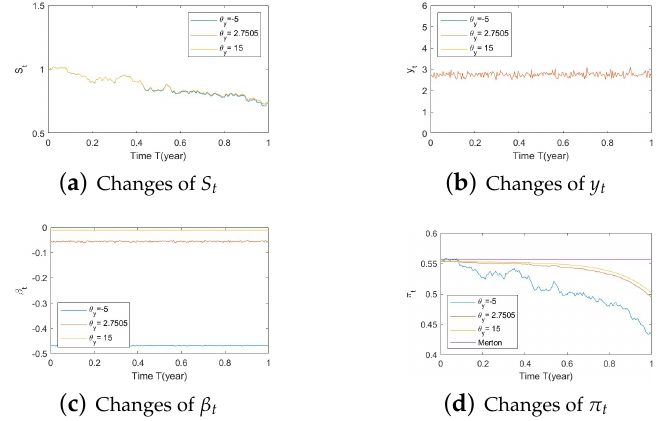
Figure A14. Illustrate the impact on ( a ) stock prices, ( b ) driver of elasticity, ( c ) elasticity of volatility, and ( d ) optimal stock allocations when varying θ y ( e . g ., θ y = − 5,2.7505,15 ) .